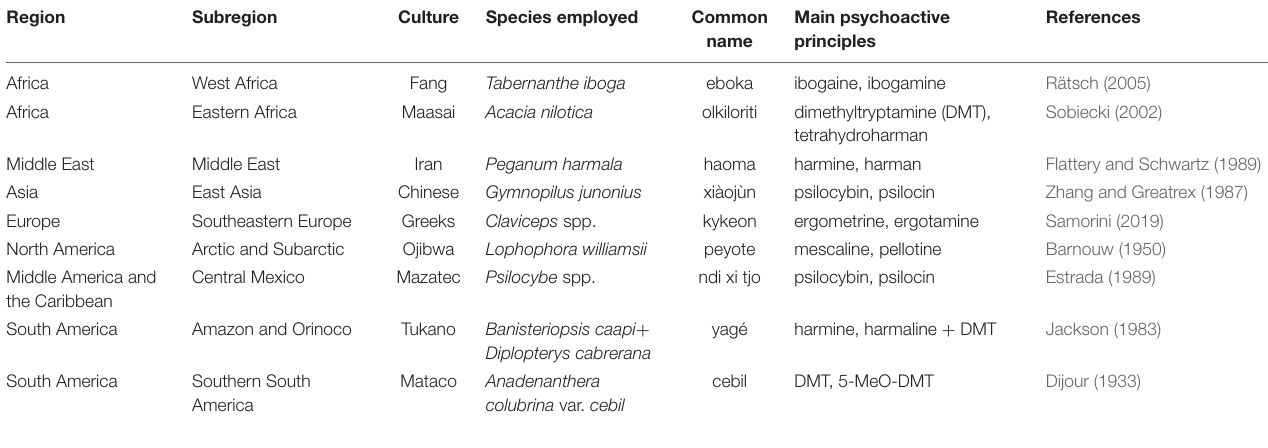
TABLE 1 | Selected societies from all over the world that employ psychedelics acting on the serotonergic system. Region Subregion Culture